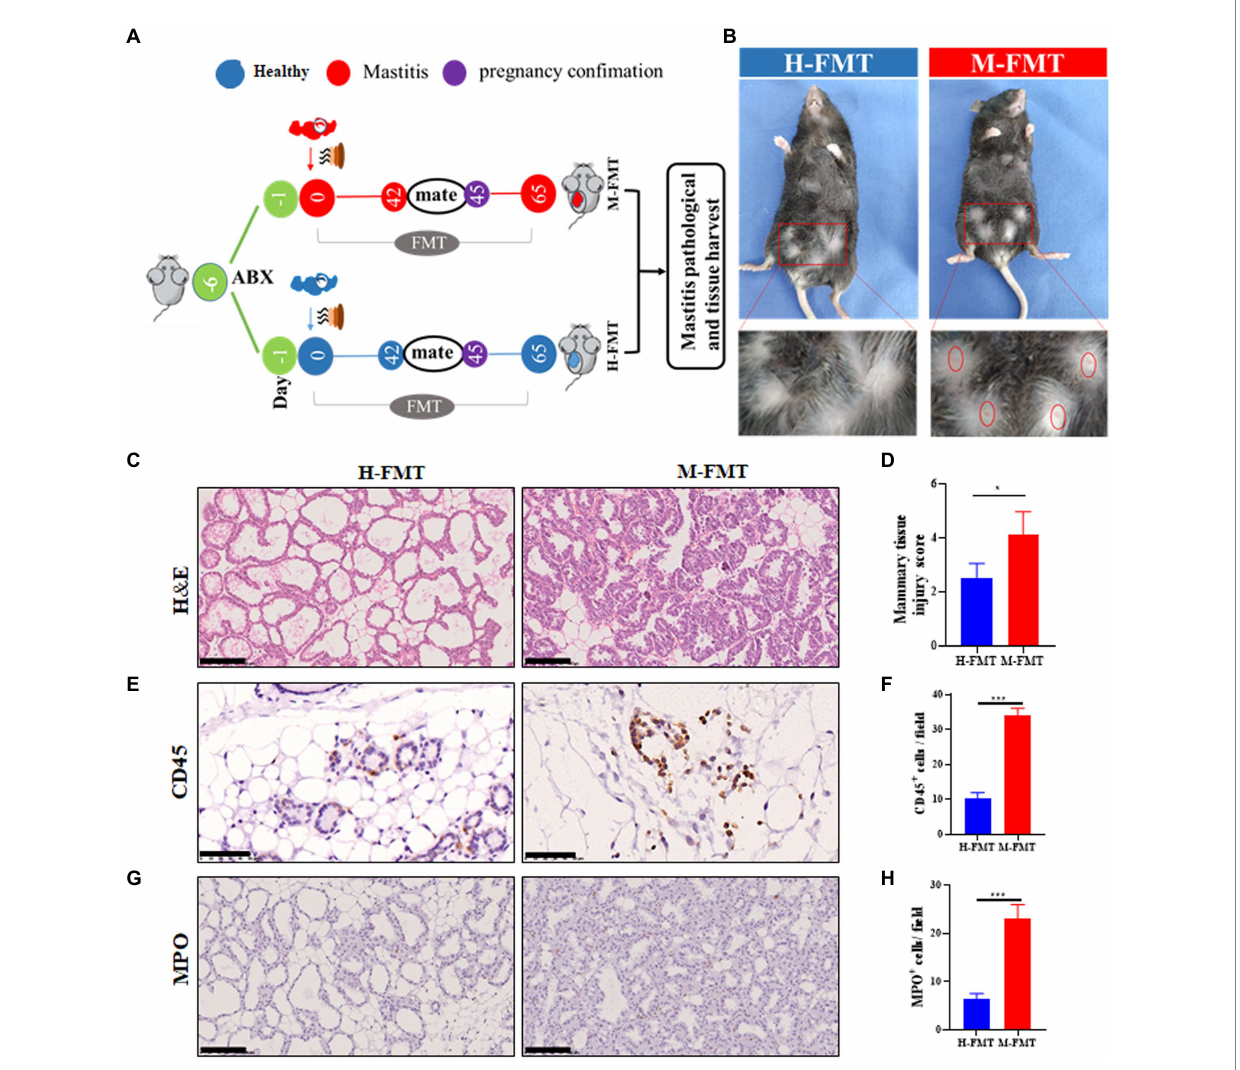
FIGURE 2 Administration of fecal bacteria from patients with lactation mastitis to mice induced a series of mastitis-like phenotypes. (A) Schematic representation of FMT. Fresh fecal from five healthy and five lactation mastitis donors were mixed and used as a single source for H-FMT and M-FMT mice. Following antibiotic treatment, the recipient mice were randomly divided and orally inoculated daily for three consecutive days and two times per week for 62 days with prepared fecal contents. (B) Pathological changes in mammary gland surface, where two abdominal mammary glands were swelling in the mastitis group of mice on day 65 after FMT. The breast of the mice was highlighted by a red frame. (C) Representative photomicrographs of hematoxylin–eosin (H&E) stained mammary tissue. (D) The injury score of mammary glands ( n = 8–10 mice per group). (E) CD45 immunohistochemical staining sections at ×400 magnification. (F) A bar graph showing the number of CD45 + cells in the H-FMT and M-FMT mice ( n = 8–10 mice per group). (G) MPO immunohistochemical staining sections at ×400 magnification. (H) A bar graph showing the number of MPO + cells in the H-FMT and M-FMT mice. The data represent the means ±SEMs ( n = 8–10 mice per group). * p < 0.05, *** p < 0.001 by t -test. Scale bar, 100 μ